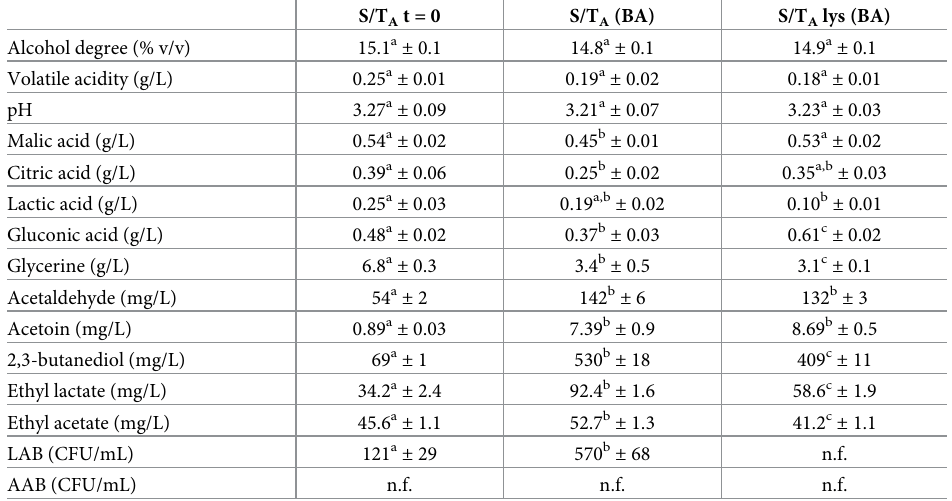
AAB (CFU/mL) n.f. n.f. n.f. S/T A t = 0 or control: initial “sobretablas” wine at t = 0; BA: biological aging; S/T A lys (BA): set of "sobretablas" classified as BA that has been treated initially with 12 g/hL of lysozyme. a,b,c Different lowercase superscript letters mean statistically significant differences between samples at p < 0.05 obtained by two-way ANOVA and Bonferroni´s multiple range (BSD) test. Results are the means ± SD of three repetitions. n.f.: not